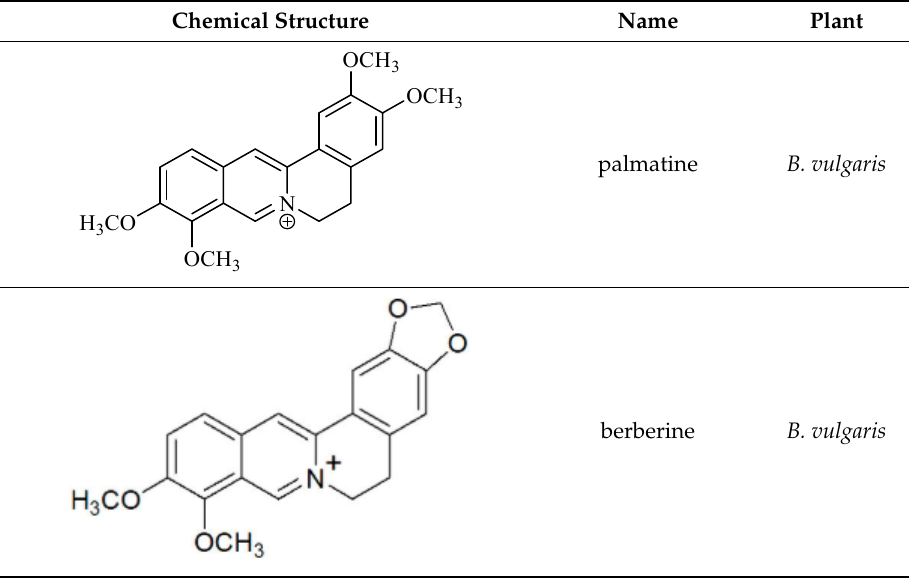
Figure 3. Stigmasterol.